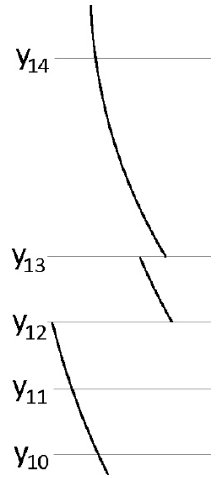
Figure 6. Part of the specific energy curve. The segments between successive elevations are continuous and differentiable.